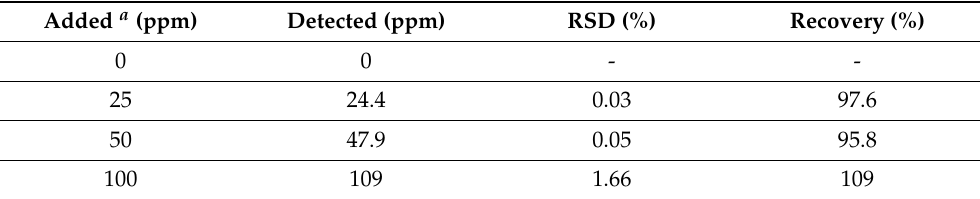
Table 2. Detection of FA in Feed with TH25 Sensor ( n = 3).